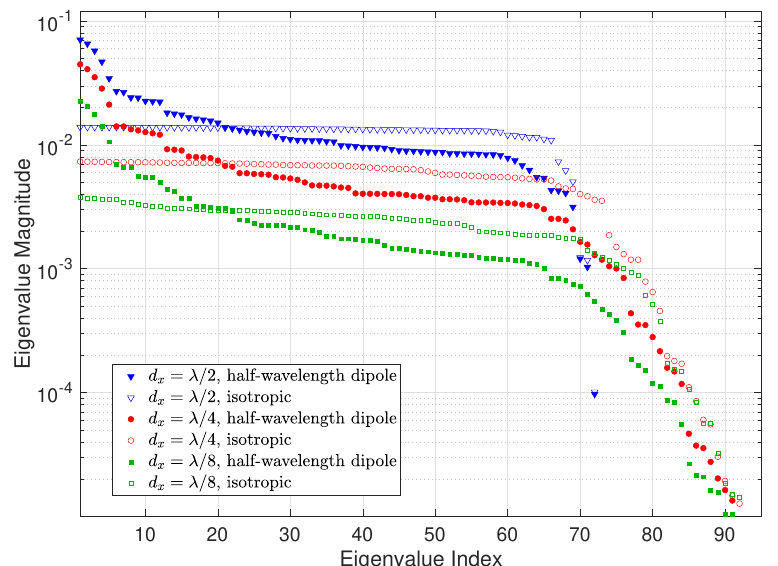
Figure 10. Eigenvalue magnitude versus eigenvalue index of the effective Rx spatial correlation matrix for half-wavelength dipoles and isotropic elements. The element spacing along the x -axis is set to λ /2, λ /4, and λ /8, respectively, with a holographic RIS size of 4 λ × 4 λ , for both without and with MC cases. The load impedance z L = z ∗ . Note that both the eigenvalue index and eigenvalue A magnitude are